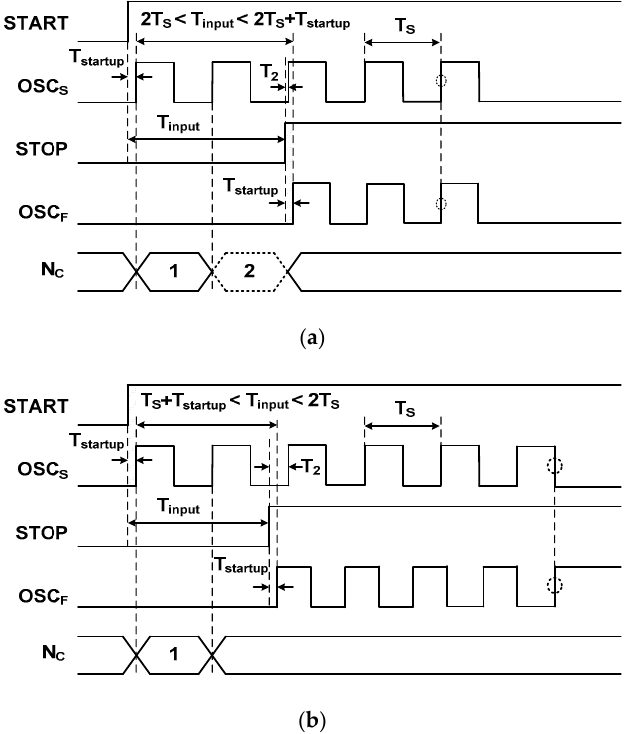
Figure 8. Waveform of two cases of the input time for a relatively small T startup . ( a ) Incorrect counting by the startup time. ( b ) Correct counting.